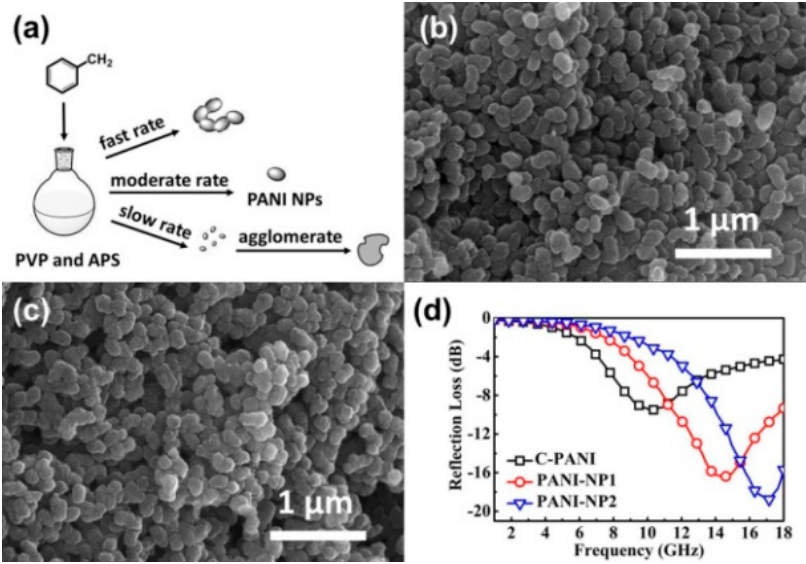
Figure 3. ( a ) Schematic illustration of the possible mechanism for polyaniline (PANI) nanoparticles (NPs); SEM images of ( b ) PANI-NP1 and ( c ) PANI-NP2; ( d ) Reflection-loss curves of conventional PANI (C-PANI), PANI-NP1, and PANI-NP2 with an absorber thickness of 2 mm in the frequency range of 1–18 GHz. Reprinted with permission from Reference [62]. APS: ammonium persulfate; PVP: Polyvinylpyrrolidone.